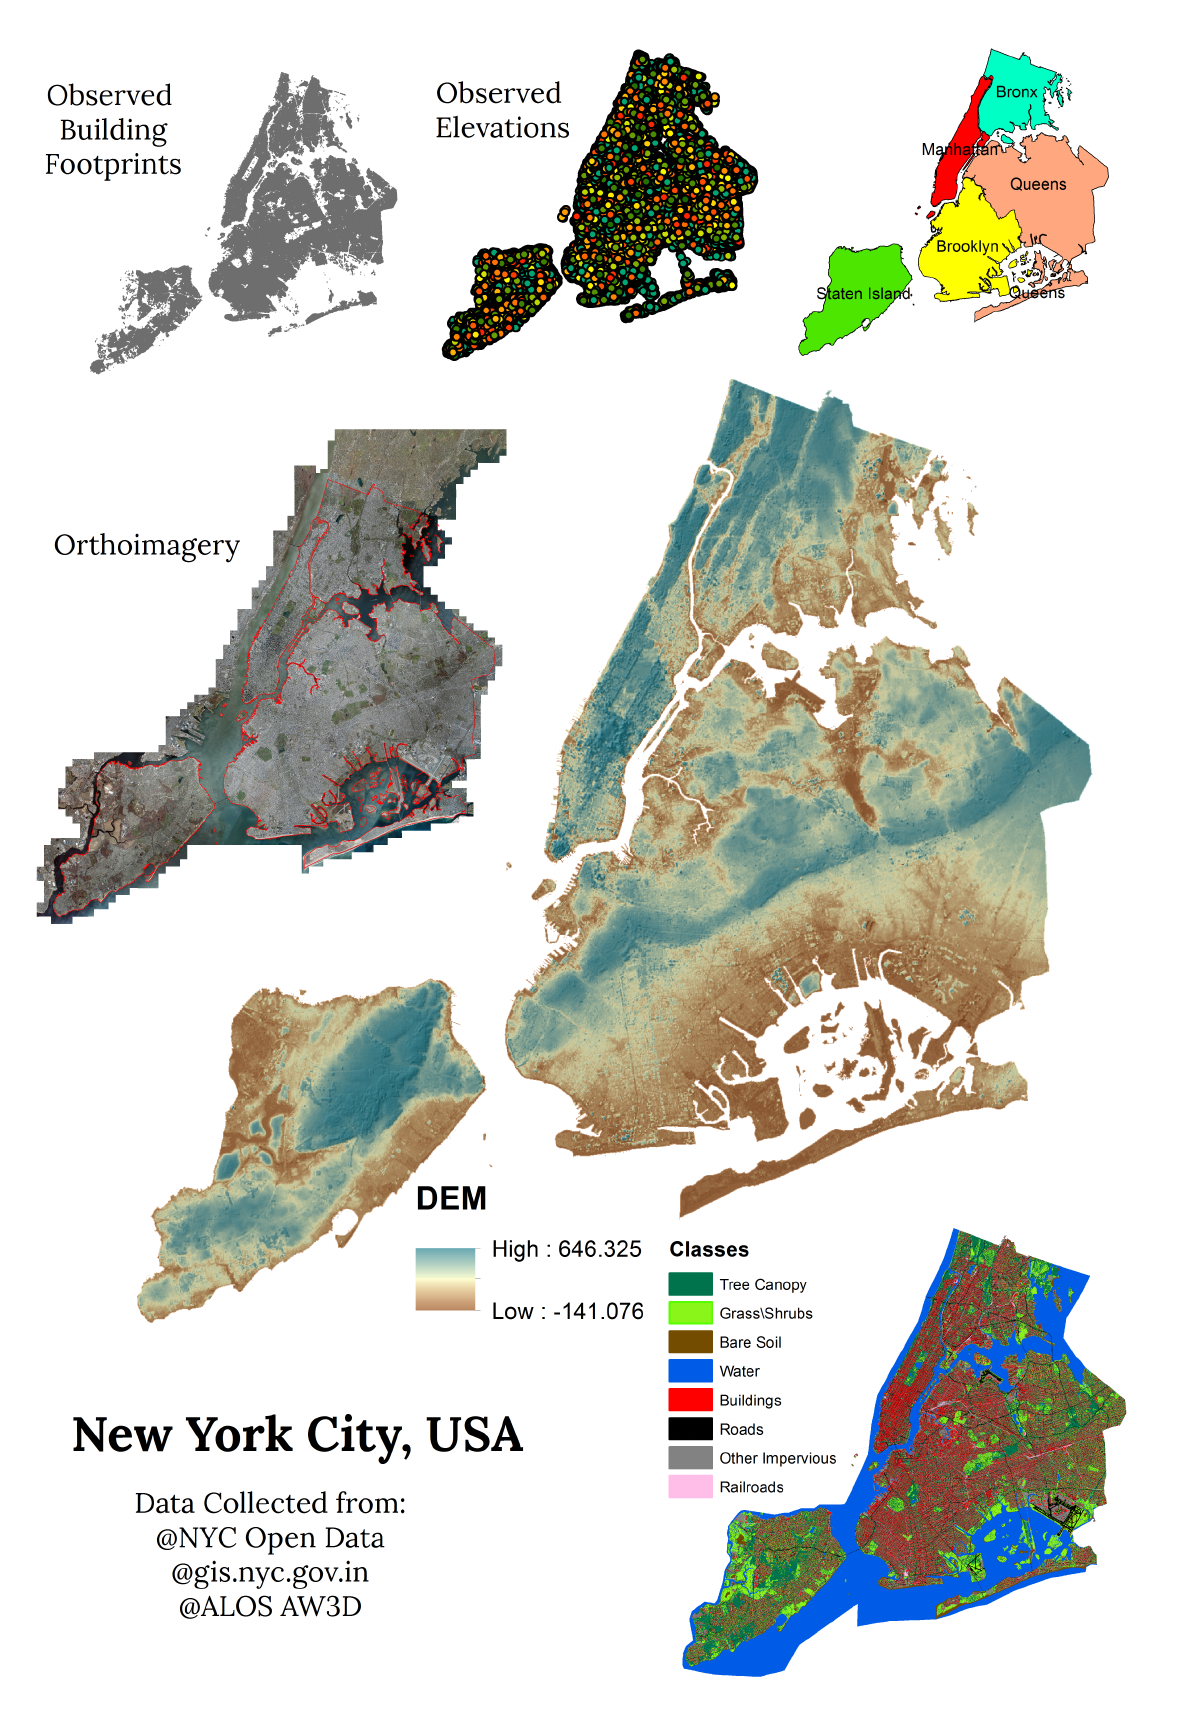
Figure 1. Five county of New York City; with observed building foot prints, elevations of ground and man-made structures, Land Use Land Cover map and ALOS AW3D shaded relief map (illumination from 315 o N and 20 o above